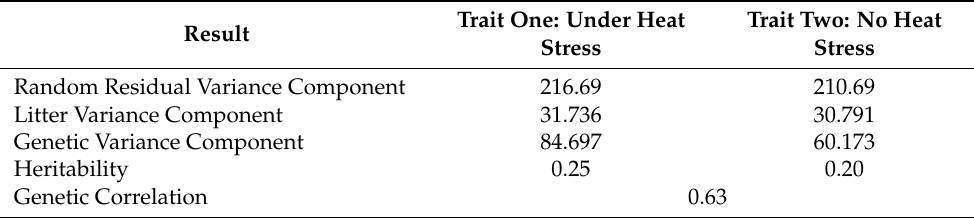
Table 2. Heritability, genetic correlation, and variance components results. Trait One: Under Heat Result